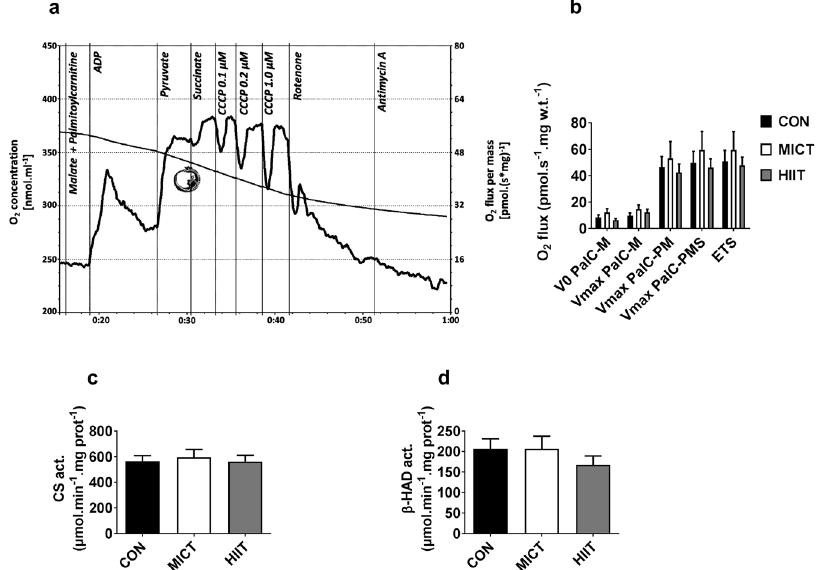
Figure 3. Oxygen concentration and mass-specific oxygen flux as a function of time were recorded in a SUIT protocol with permeablised gastrocnemius. 0.02 mM palmitoyl-carnitine (Pal-C) and 2 mM malate were added in the chambers before the fibres were added. (ADP: 2.5 mM adenosine diphosphate; P: 5 mM pyruvate; S: 10 mM succinate; U: Carbonyl cyanide m-chloro phenyl hydrazine (CCCP); Rot: 0.5 µ M; AmA: 2.5 µ M Antimycin A). ( a ) Representative measurement of mitochondrial respiration. ( b ) Effects of MICT and HITT on mitochondrial respiration. ( c ) Citrate synthase and ( d ) β -hydroxyacyl-CoA dehydrogenase activities. Data are expressed as means ±